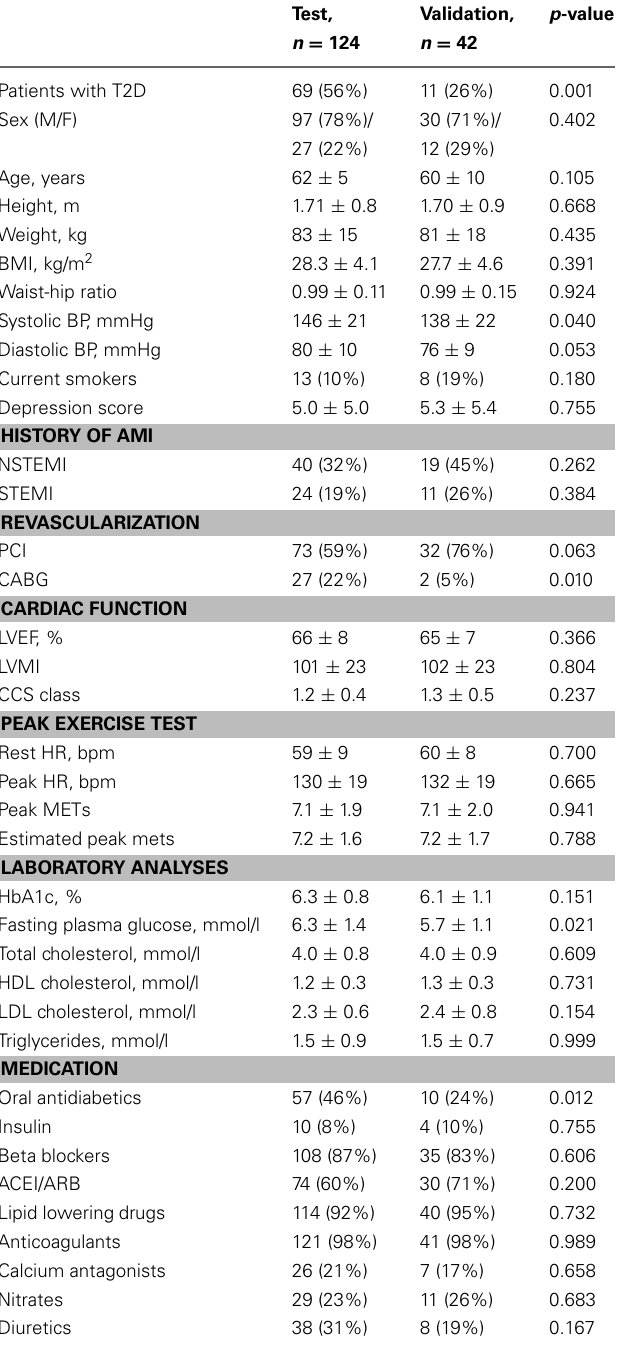
Table 1 | Demographic characteristics of study